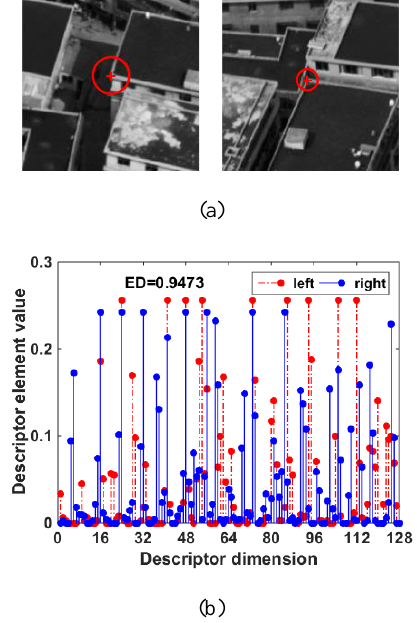
Figure 1. An example of viewpoint change and parallax discontinuity between wide-baseline images in urban area. (a) shows a pair of oblique images. The two crosses denote a pair of correspondence. The red circle around each point denotes the feature region determined based on SIFT (Lowe, 2004). (b) shows the SIFT descriptors of the two points and the corresponding Euclidean distance (ED). The feature descriptors are dissimilar and difficult to match